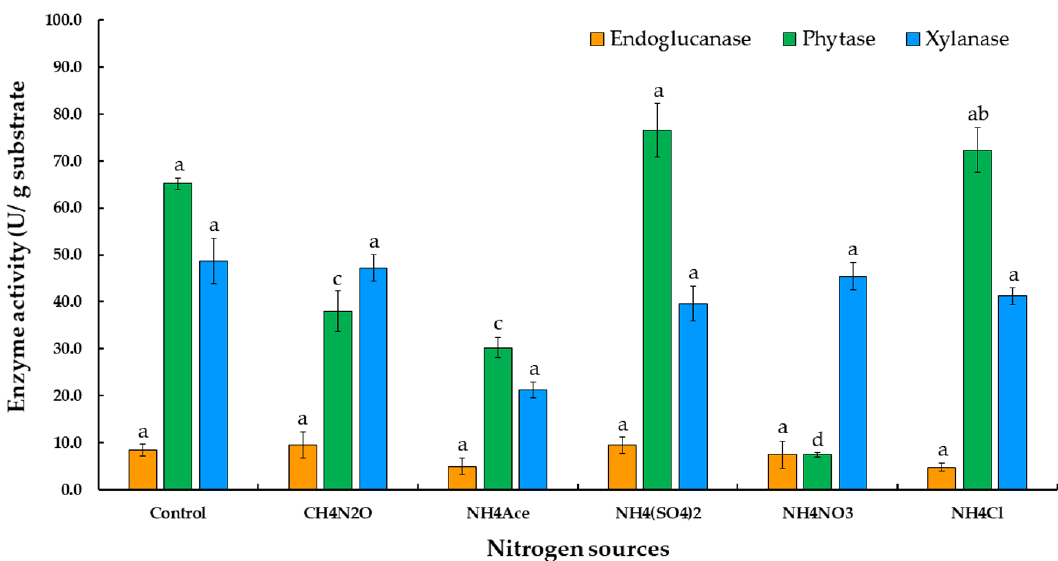
Figure 3. Phytase, endoglucanase, and xylanase production by Thermoascus aurantiacus SL16W with various nitrogen sources under semi-solid state fermentation. Average ± standard deviation from three replicate experiments. Different letters in the same column are considered significantly different according to Duncan’s multiple comparison test ( p ˂ 0.05).